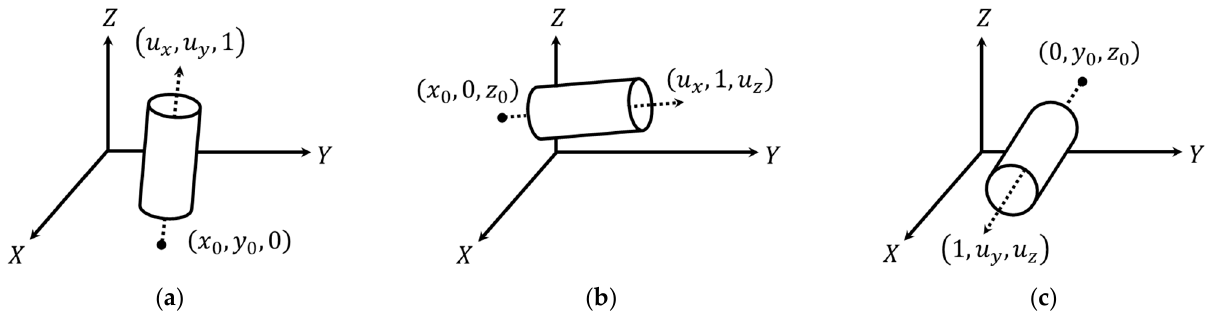
Figure 7. Different options for representing planar features showing the normal vectors to the planes (defined by the eigenvector corresponding to the smallest eigenvalue) that are mainly along the ( a ) Z -axis (i.e., the eigenvector component along the Z -axis is larger than those along the X and Y axes), ( b ) Y -axis (i.e., the eigenvector component along the Y -axis is larger than those along the X and Z axes), and ( c ) X -axis (i.e., the eigenvector component along the X -axis is larger than those along the Y and Z axes).